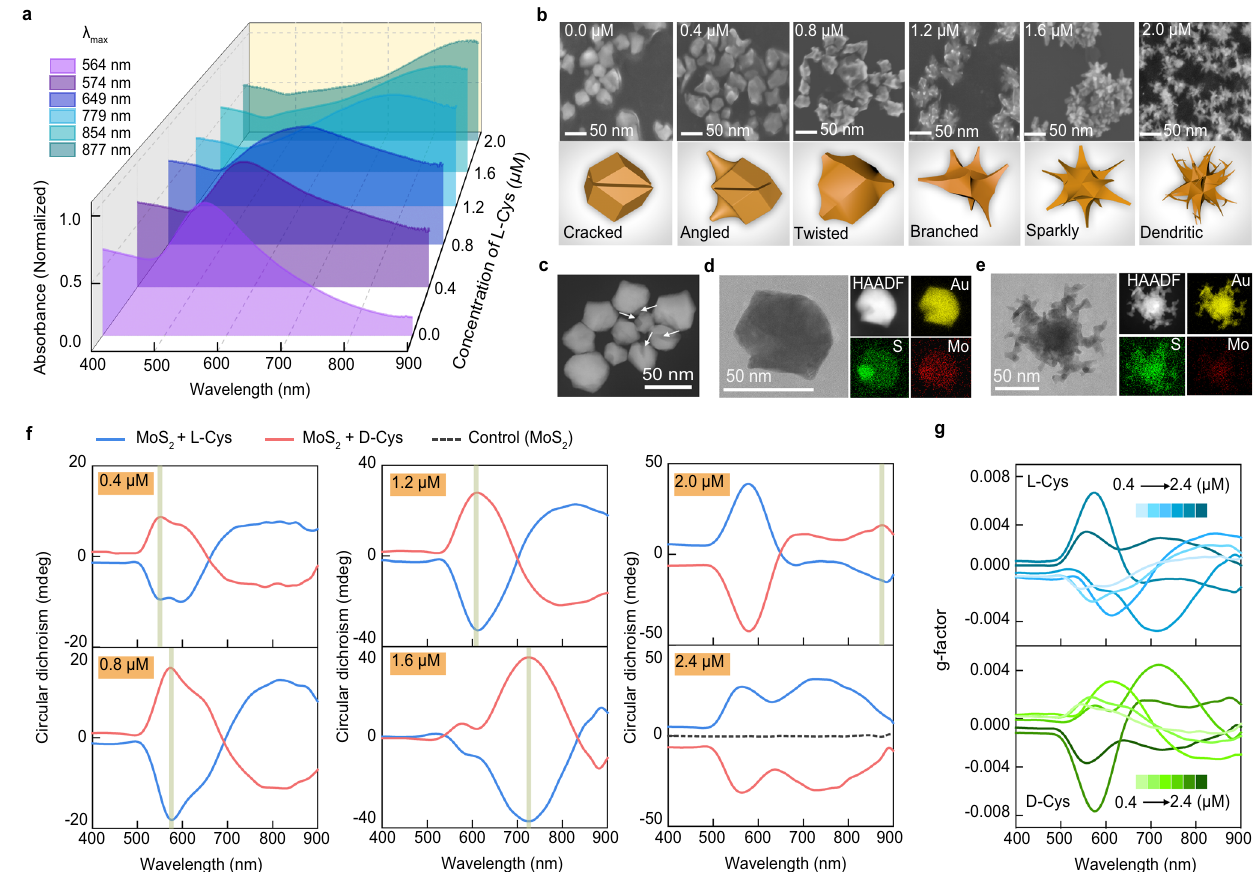
Fig. 1 | Spectroscopic and morphological identi fi cation of hybrid nanos- tructures formed by the enantiomers of cysteine. a , b Optical spectra ( a ), SEM images and corresponding simulated morphologies ( b ) of as-synthesized nanos- tructuresbasedongrowthwithseedsofexfoliatedMoS 2 nanosheetsintheabsence andpresenceofdifferentconcentrationsofL-Cys(0.4 – 2.0 μ M). c , d Dark- fi eldTEM image( c ),TEMandEDXelementscan( d )ofAu/MoS 2 nanostructuresformedinthe absence of L-Cys. e TEM and EDX element scans of Au/MoS 2 nanostructures